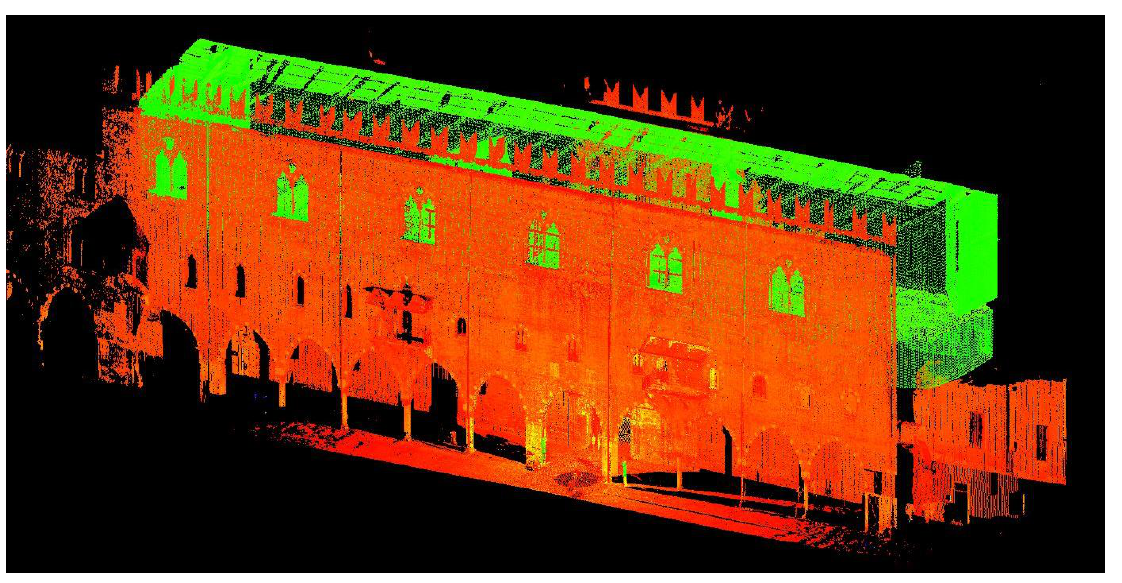
Figure 5. Palazzo del Capitano point cloud in